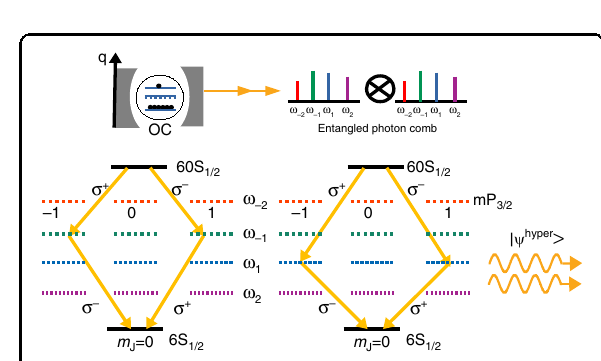
Fig. 4b. The correlation between different photon fre- quencies was calculated from the coincidence probability between photons fi ltered at the two frequencies as shown in Fig. 4c, d.